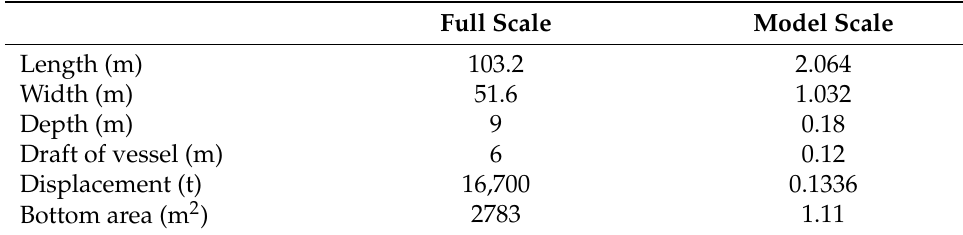
Table 1. Parameters of the vessel. Table 2. Parameters of the CBF.